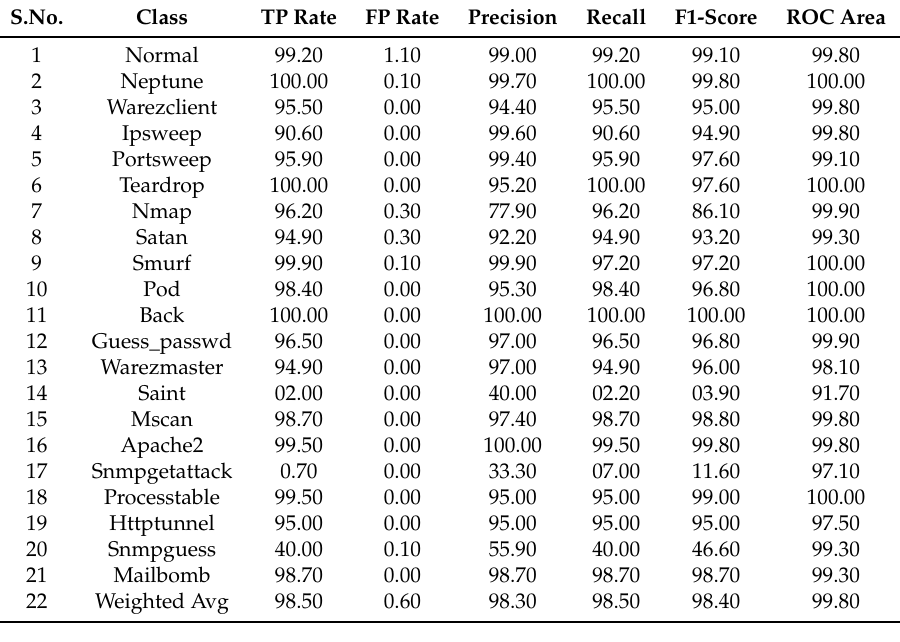
Table 40. Multiclass classification report for NSLKDD using the Adaboost Random Forest.